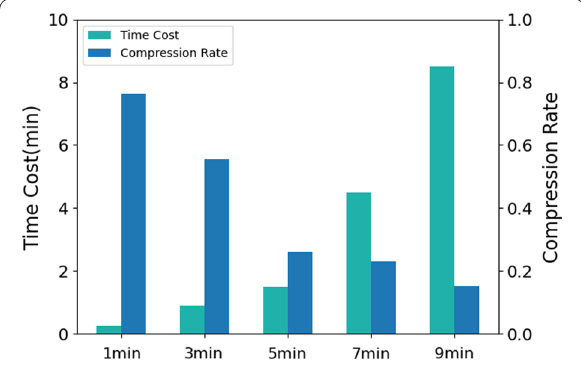
Fig. 9 Compression rate and time cost under different buffer